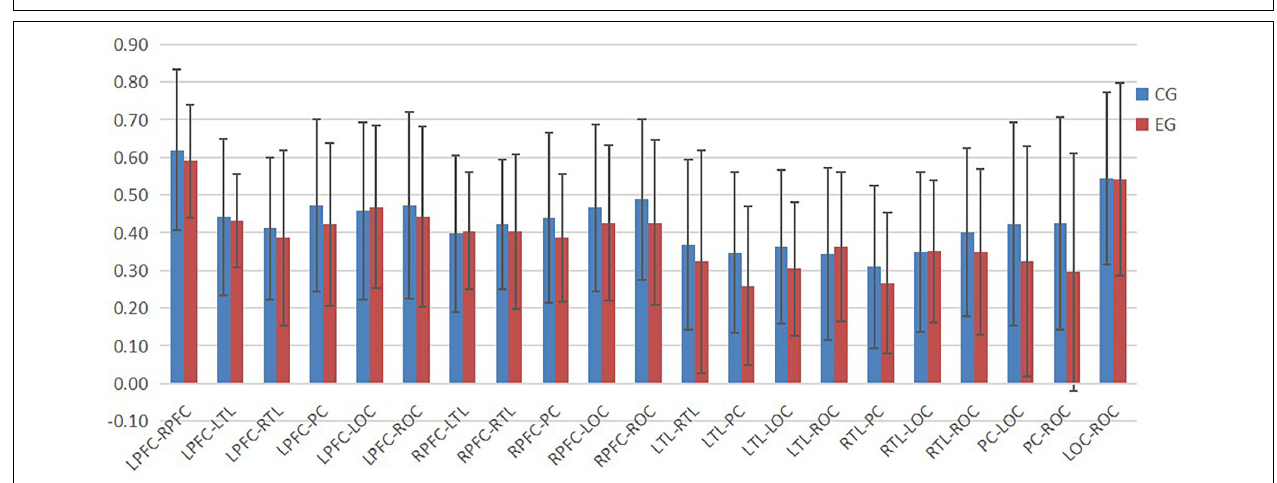
Frontiers in Aging Neuroscience |